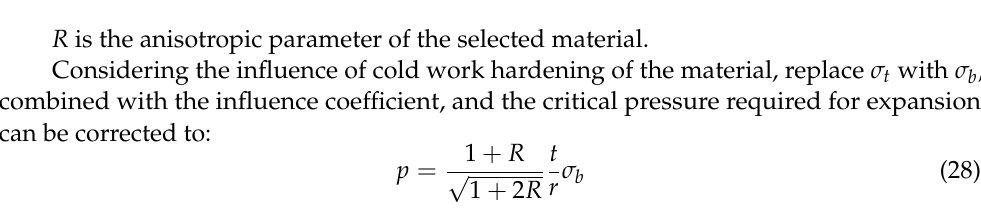
can be corrected